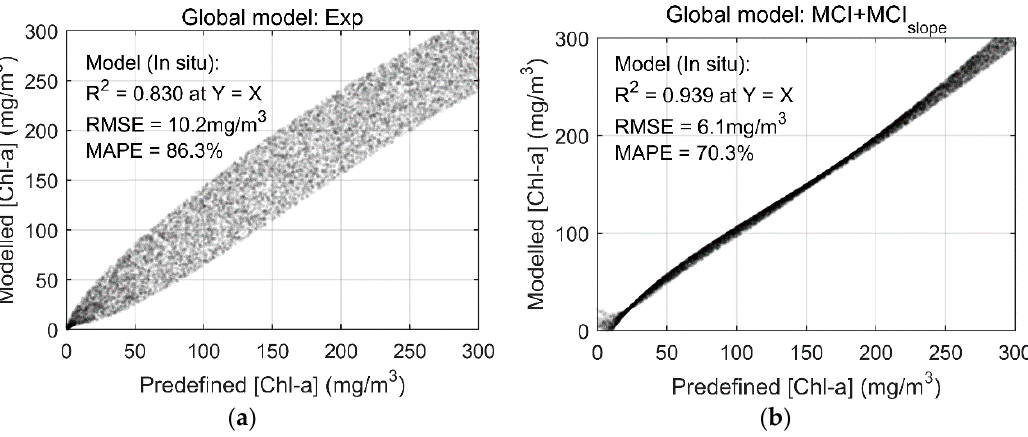
Figure 7. Comparison of global [Chl-a] fitting using ( a ) only MCI and ( b ) both MCI and its slope. The regression model used in ( a ) is the best performance model (exponential) in Table 2. The regression model in ( b ) is a quadratic polynomial regression from MCI and its slope to [Chl-a].